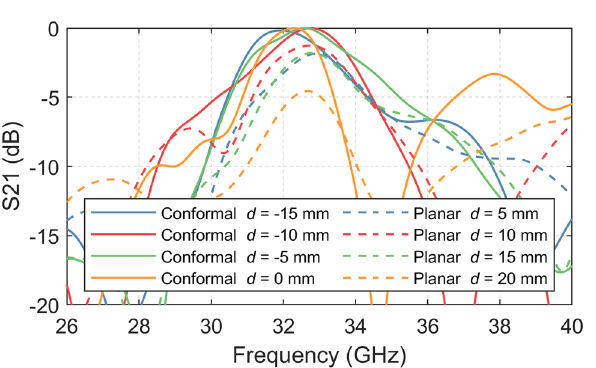
Figure. 4. Simulated bandpass performance of the conformal FSS and the finite planar FSS with different d